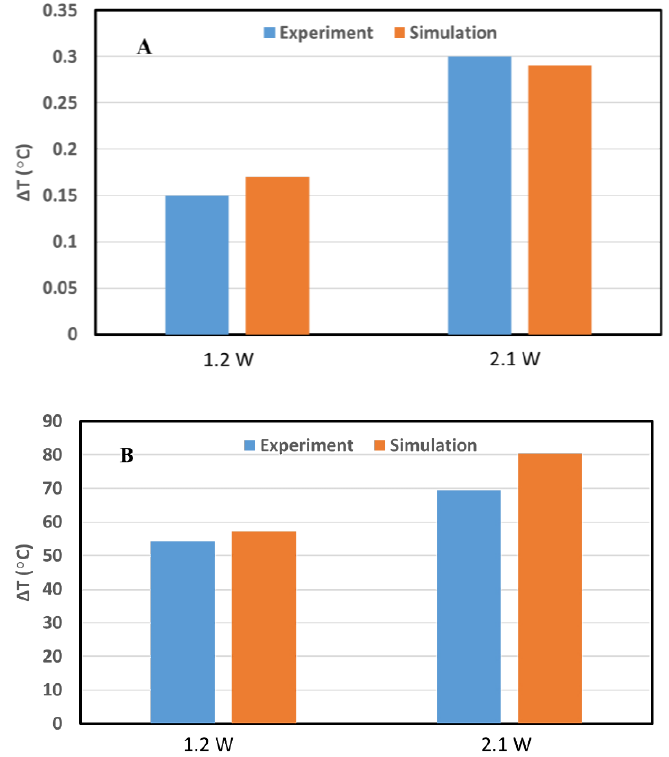
Figure 6. Comparison between simulation and experiment of the temperature increment during the 30 s laser irradiation in ( A ) water alone and ( B ) GNR suspensions for the laser powers of 1.2 and 2.1 W. For the powers of 1.2 W and 2.1 W, relative error is 11.76% and 3.45%, respectively, for water alone and is 5.28% and 13.48%, respectively, for GNR suspension.